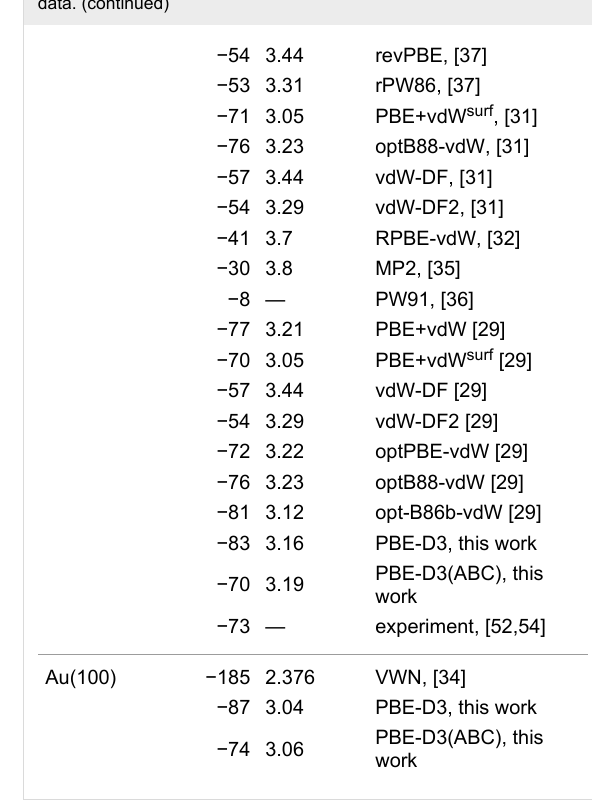
Table 3: Comparison of adsorption energies E ads in kJ/mol and adsorption distances d in Å with available theoretical and experimental data.